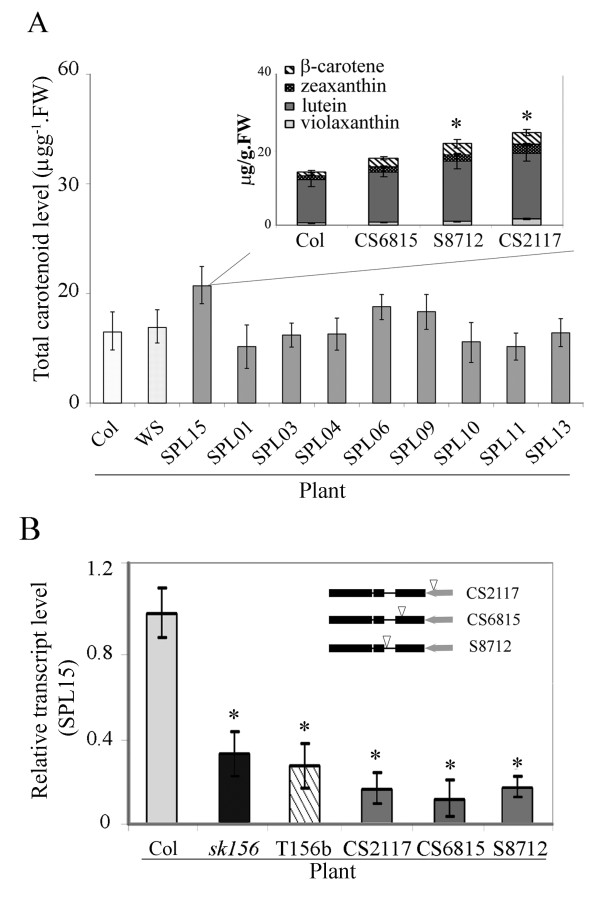
Involvement of SPL15 in phenotypic alteration of sk156. (A) Carotenoid levels in SPL loss-of-function mutants specifying nine SPL genes, including SPL15. SPL15 SALK lines in insert show details on specific carotenoid changes. (B) SPL15 transcript levels in sk156, SPL15-related Salk lines, and T156b relative to WT (Col, set at 1). Insert shows schematic diagrams of T-DNA insertion sites ‘∇’ in SPL15 SALK mutants CS2117, CS6815 and S8712.Duncan's multiple range test showed significant differences (*) of the means (± standard deviation) between sk156 and WT (Col or WS) at p < 0.05.